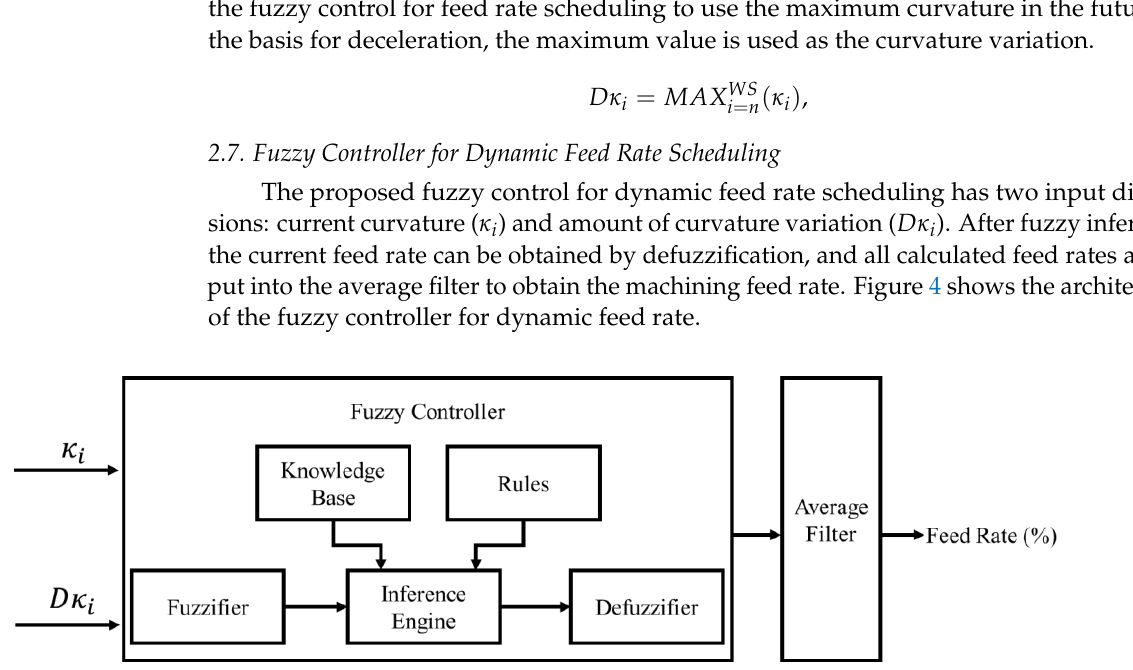
Figure 4. Architecture of fuzzy controller for dynamic feed rate scheduling.